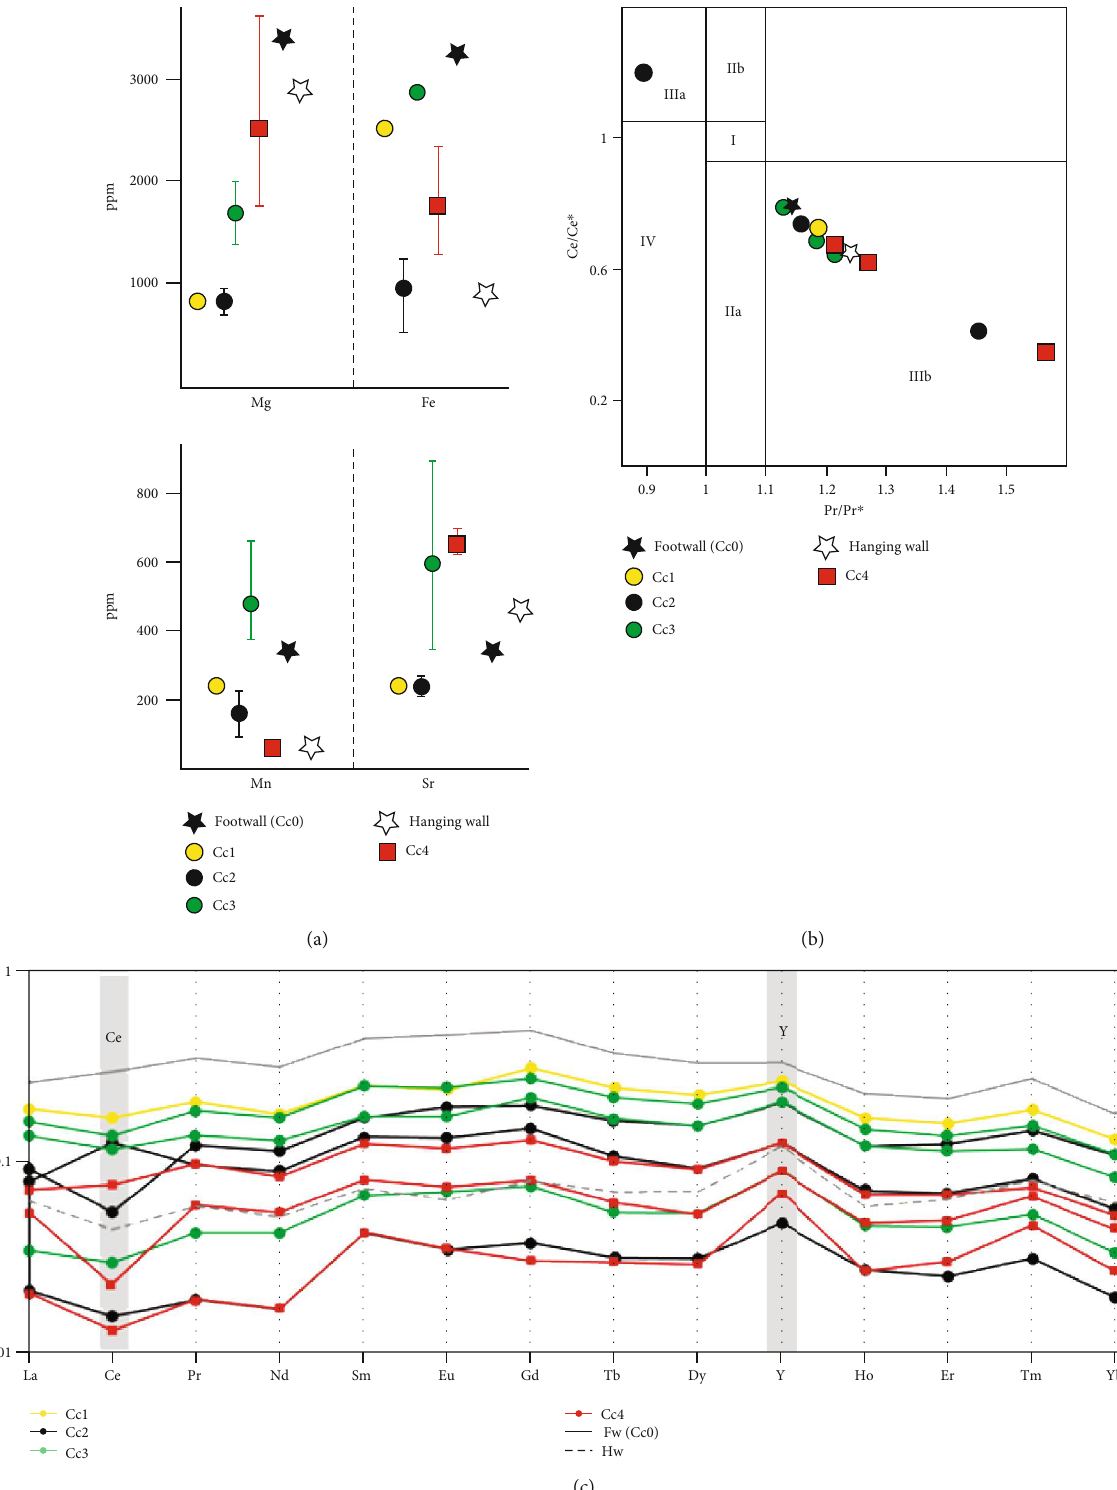
Figure 12: (a) Elemental composition (Mg, Fe, Mn, and Sr) in ppm of calcite cements and host rocks. Bars indicate maximum, minimum, and average composition. (b) PAAS-normalized Ce/Ce ∗ vs. Pr/Pr ∗ crossplot showing the Ce and Pr anomalies of calcite cements and host rocks using the method of [62] modi fi ed by [63]. Field I: no anomaly. Field IIa: positive La anomaly and no Ce anomaly. Field IIb: negative La anomaly and no Ce anomaly. Field IIIa: positive Ce anomaly. Field IIIb: negative Ce anomaly. Field IV: positive Ce and La anomalies. (c) PAAS-normalized rare elements and yttrium (REY) patterns of calcite cements and host